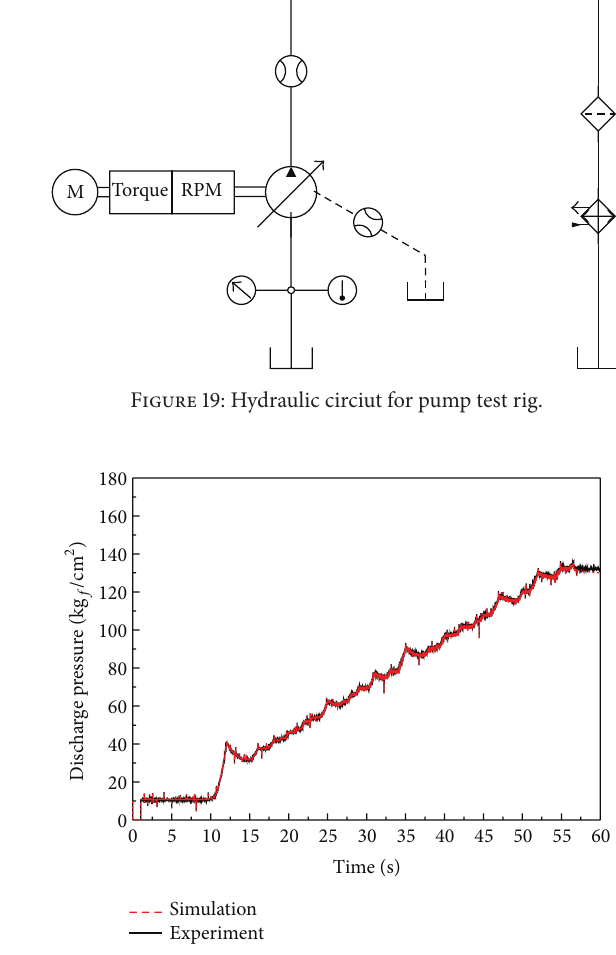
Figure 20: Condition of load pressure for constant power regulator